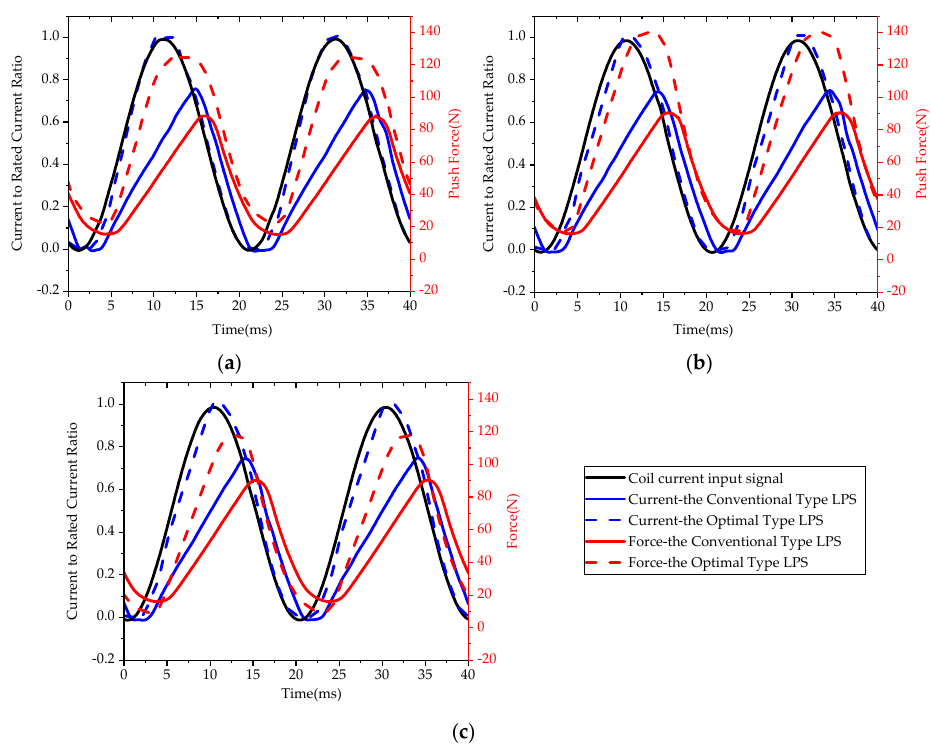
Figure 13. The 50-Hz current input signal response comparison of the three types LPS: ( a ) start position of the working stroke; ( b ) middle position of the working stroke; ( c ) end position of the working stroke.